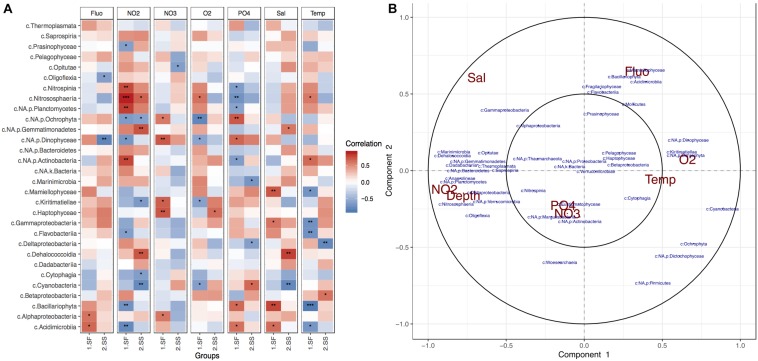
Physical and chemical factors influencing BoB photic planktonic microbial communities. (A) Pearson correlation heatmap for the top 30 most abundant taxonomic classes and environmental variables per layer. Stars represent significance of correlation. (B) Circle correlation plot, where relationships between phylotypes (blue) and environmental factors (red) are presented in terms of radial distances and their cosine angles (González et al., 2012; Rohart et al., 2017). Sharp and obtuse angles between variables represent positive and negative correlations, respectively, while perpendicularity presents no correlation. Strength of correlations is represented by distance from the radial origin.